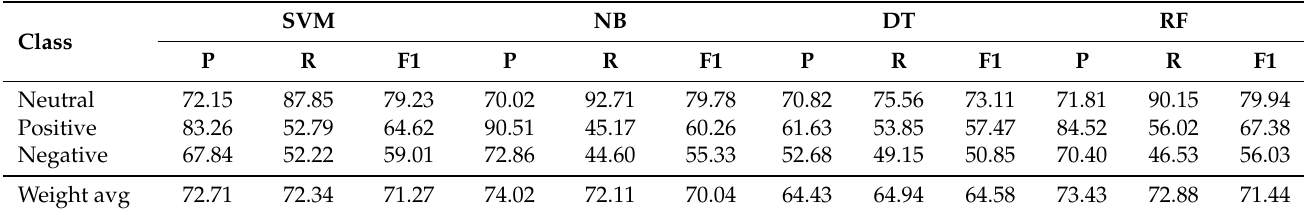
Table 11. Performance of CML models using tf ∗ idf